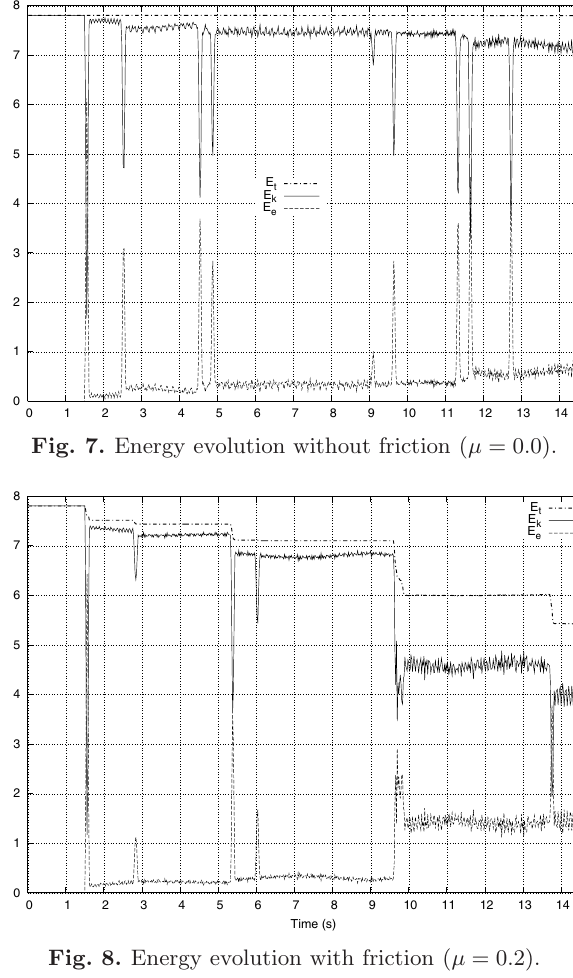
Fig. 8. Energy evolution with friction ( μ = 0 . 2).